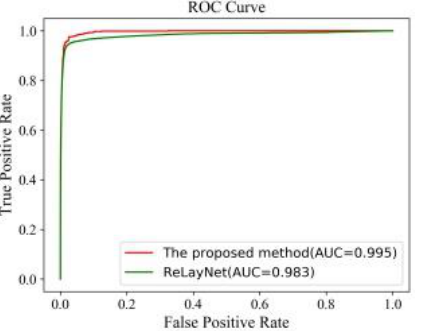
Figure 18. Comparison of ROC curves with expert 2 annotations as the ground truth.